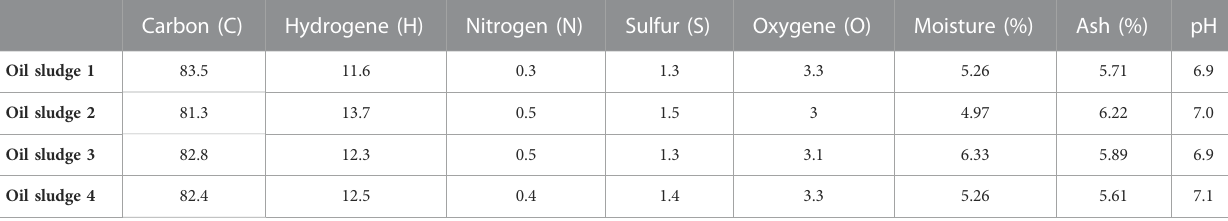
TABLE 1 The elemental characteristics and properties of the different types of investigated industrial oil sludges. Carbon (C)